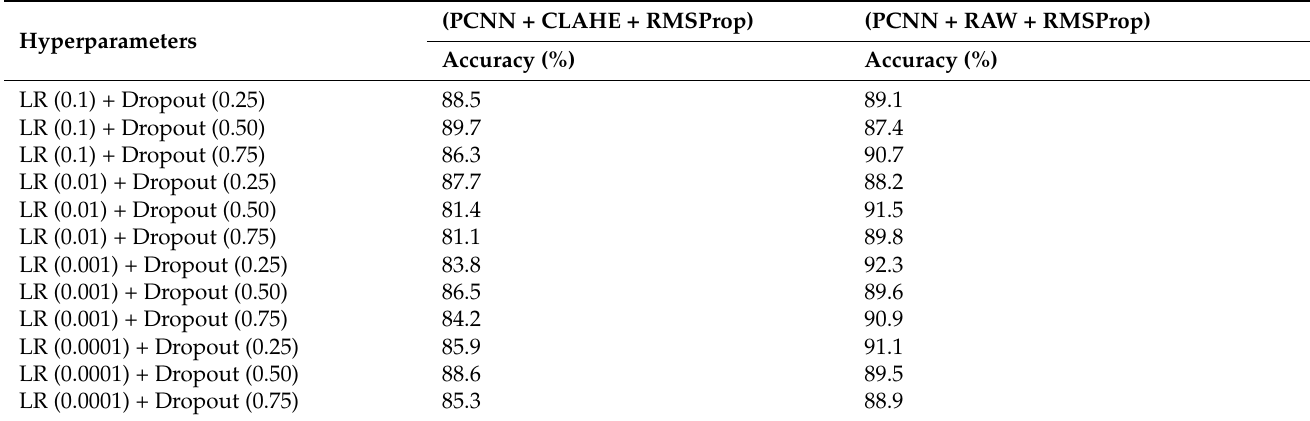
Table 8. Performance evaluation of the proposed PCNN based on different hyperparameter tuning on our dataset with RMSProp optimizer.